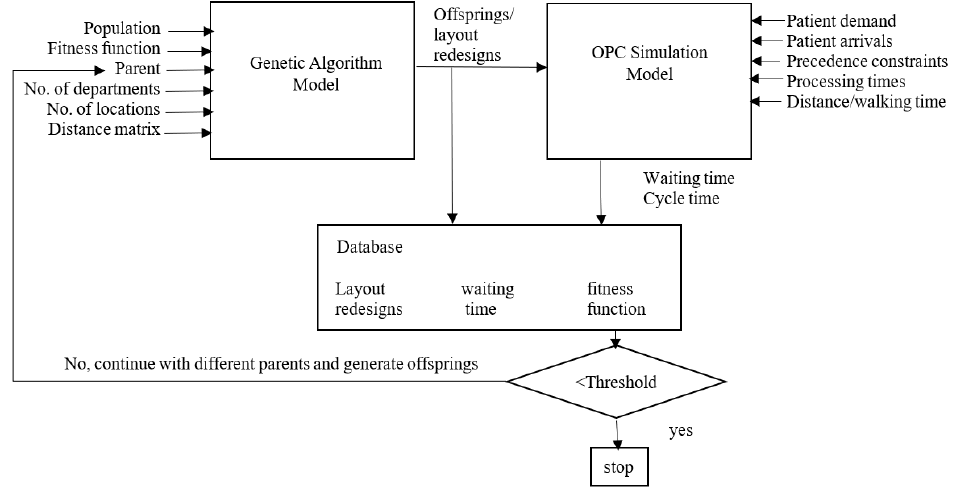
Figure 4. Complete optimization model.